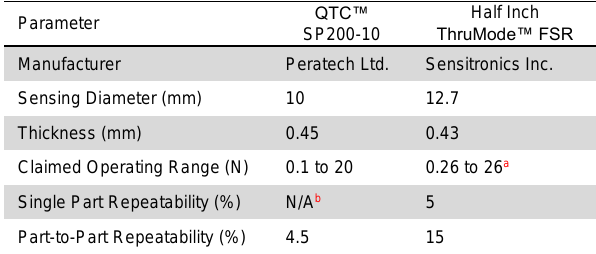
Table 1: Sensor model